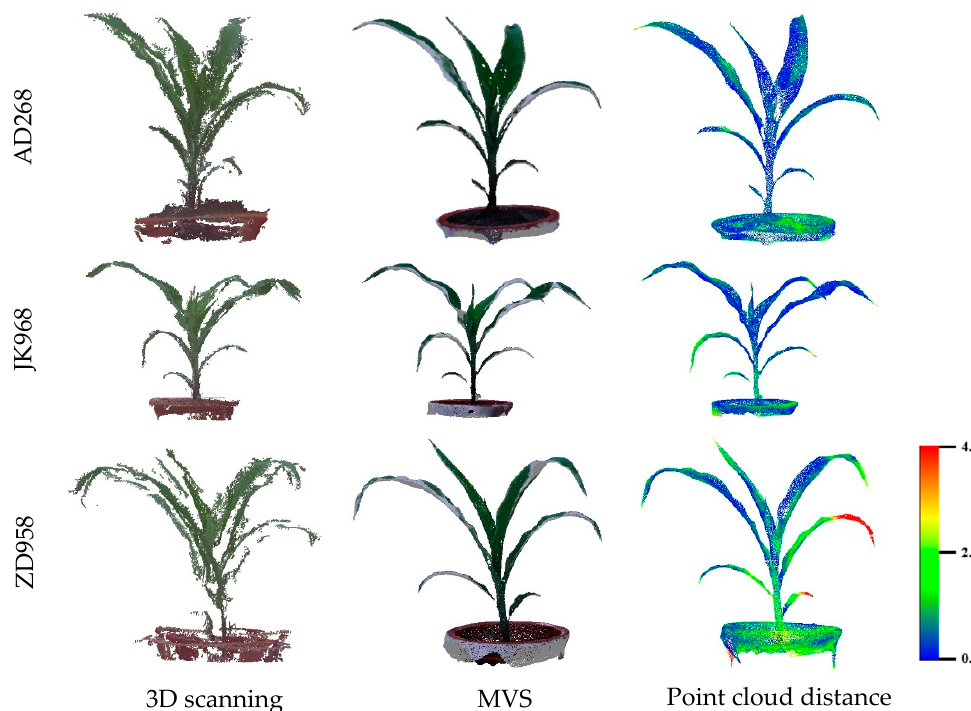
Figure 4. Maize plants point clouds comparison derived using 3D scanning and MVS reconstruction at V5 stage (20th day after sowing).